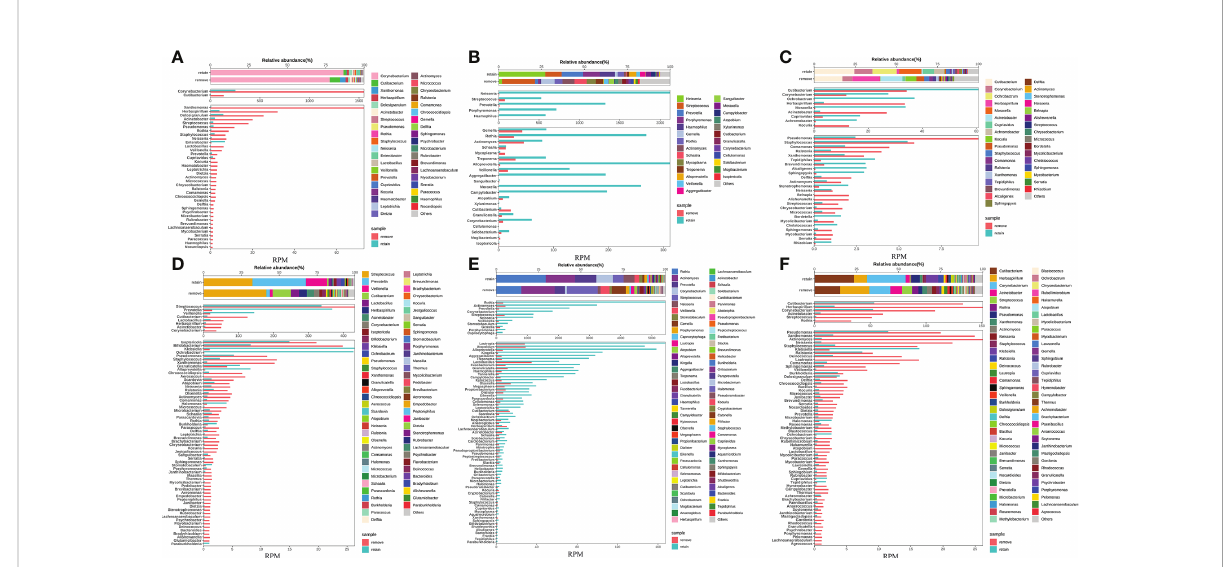
FIGURE 4 Removing host DNA detection work fl ow show identical species abundance of bacteria with the work fl ow of retaining host DNA and will not cause the loss of RNA from bacterial species. (A-F) Eight samples simultaneously performed the work fl ow of removing and retaining host DNA and compared the bacterial species composition between the two work fl